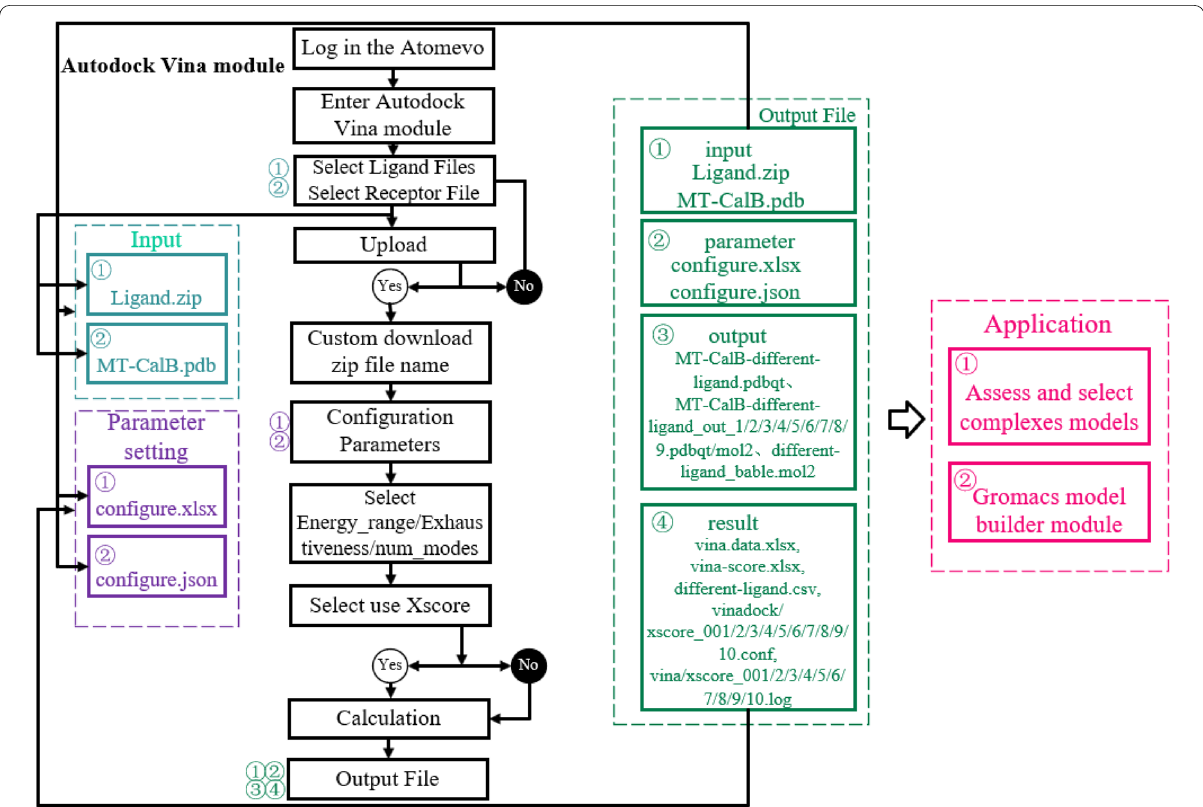
Fig. 2 Flow diagram of autodock vina